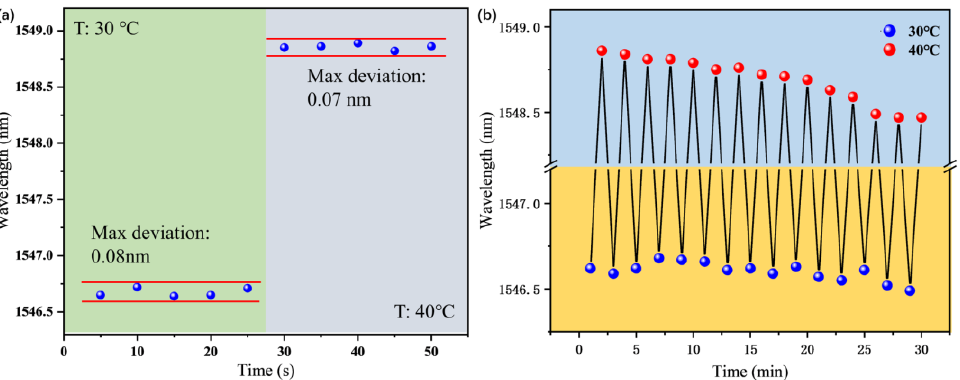
Figure 5. ( a ) Stability test of HCSP-1 between the temperature of 30 °C and 40 °C. ( b ) Repeatability test of HCSP-1 between the temperature of 30 °C and 40 °C.